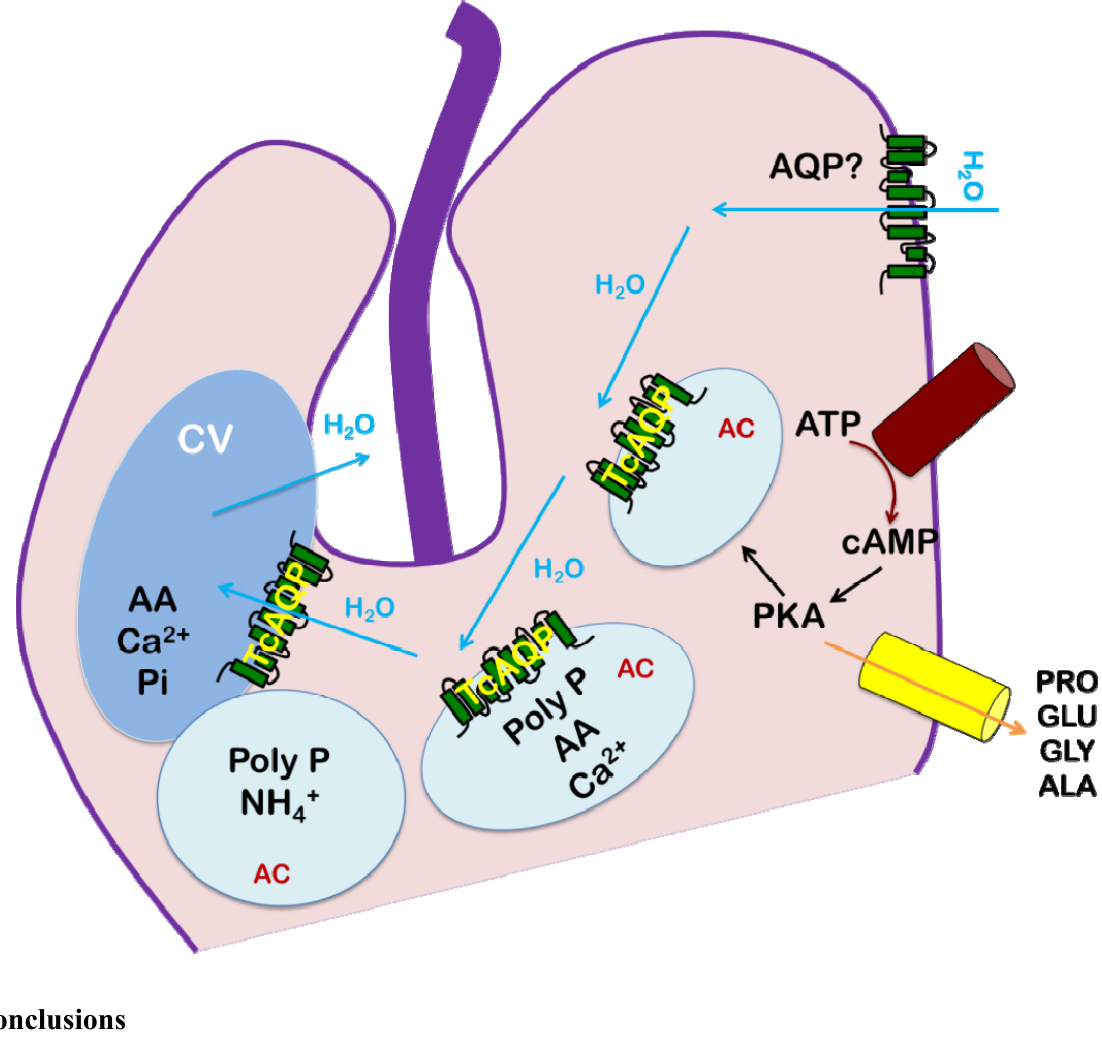
Figure 4. Osmoregulation mechanism of T . cruzi . Volume increase due to hypo-osmotic stress triggers the production of cAMP. Elevated cAMP levels induce protein kinase activity that promotes fusion of acidocalcisomes (AC) with the contractile vacuoles (CV) and amino acid release. The fusion translocates the TcAQP from AC to CV and this is believed to aid the contractile vacuole in water sequestration followed by release into the flagellar pocket. AA: amino acids, PolyP: polyphosphate, Pi: inorganic